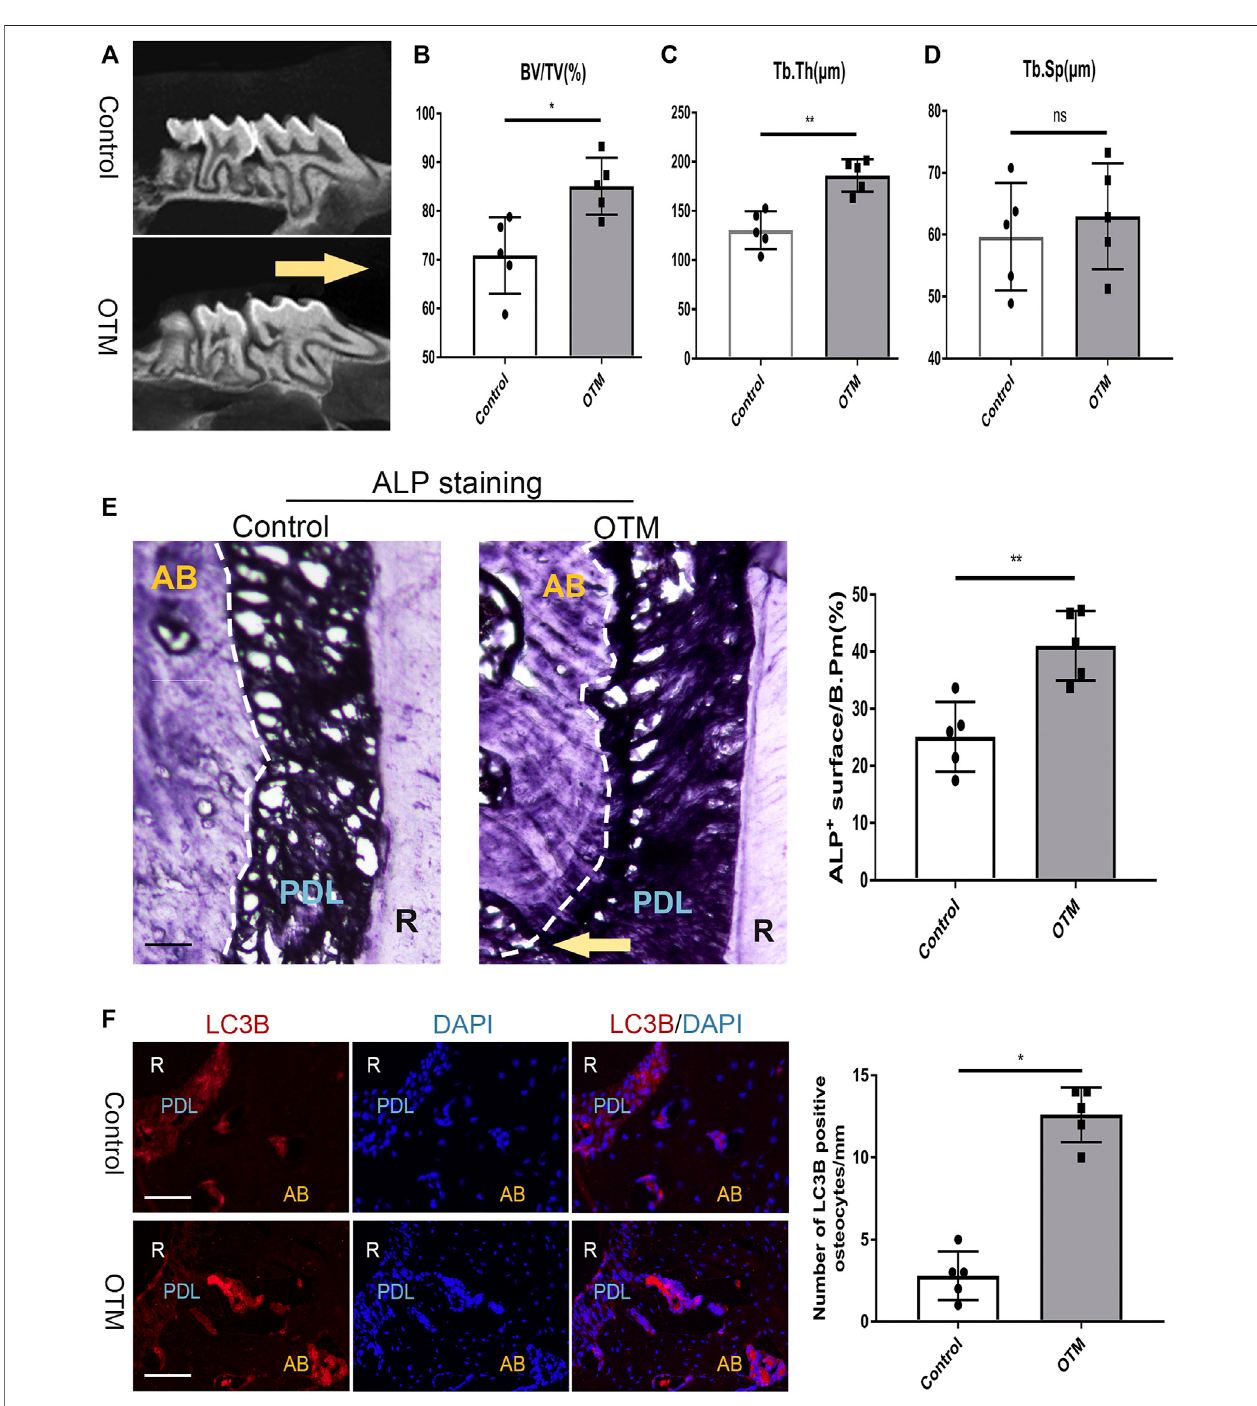
FIGURE1| Orthodontictooth movementactivated osteocyteauthophagy. (A) Representataive images showingthedistance between the fi rstand second maxillary molars after 7 days of orthodontic tooth movement. Yellow arrow showed the direction of tooth movement. Scale bar (cid:2) 500 μ m, n (cid:2) 5. (B – D) Micro-CT analysis of avveolar bone volume. Ration of trabecular bone volume/total volume(B-V/TV%), trabecular thickness(Tb.Th) and trabecular separation (Tb.Sp) were measured. (E) Frozen sections of the maxillary fi rst molar were stained by ALP. The quanti fi cation of ALP + surface/B.Pm(%). Yellow arrow showed the direction of tooth movement. Scale bar (cid:2) 50 μ m. (F) maxillary bone adjacent frozen sections were subjected to IF staining of osteocytes with anti-LC3B. DAPI was counterstained to show the nuclei (blue). The quanti fi cation of LC3B + osteocytes/mm. White dashed lines respresented the bone surface. Scale bar (cid:2) 50 μ m. All data were showed as mean ± SD.* p ˂ 0.05 vs . control.